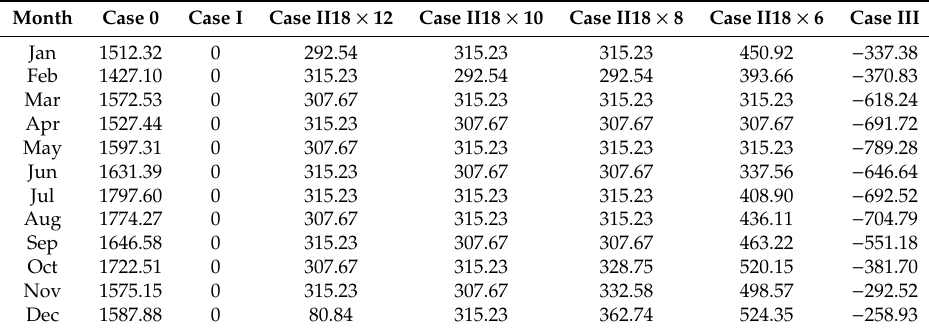
Table 4. Economic electric consumption (EUR) in the town.